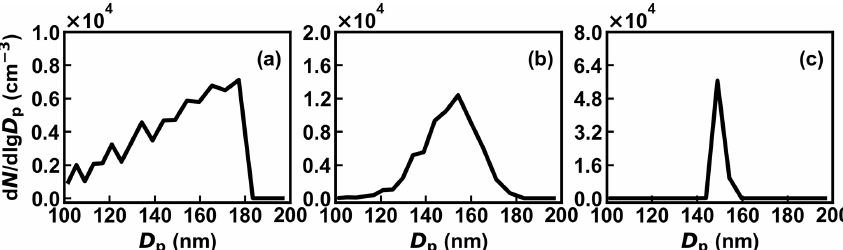
Figure 5. Aerosol particle size distributions after hygroscopic growth at a RH of 90% for three aerosols with χ of 0.653 (a) , 0.884 (b) , and 1 (c) . Each of these three populations has the same κ mean of 0.305 and contains 1000 aerosol particles with dry diameters of 100nm.